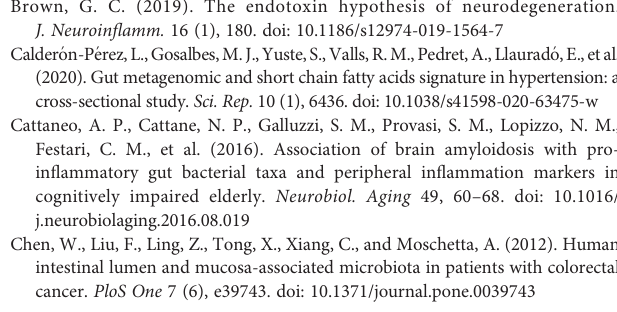
Supplementary Figure 1 | (A, B) OTU analysis of three groups. The horizontal axis represents the number of samples observed, and the vertical axis represents thetotal/corespeciesofallsamplesunderagroupingcategory.PanOTUisthesum of the OTU contained in all samples, which is used to observe the increase of the total number of OTU as the number of samples increases. Core OTU refers to the number of common OTU in all samples, which is used to observe the decrease of the number of common OTU as the number of samples increases. Red, blue, and green curves represent the NC, SCD, and aMCI groups ’ OTU